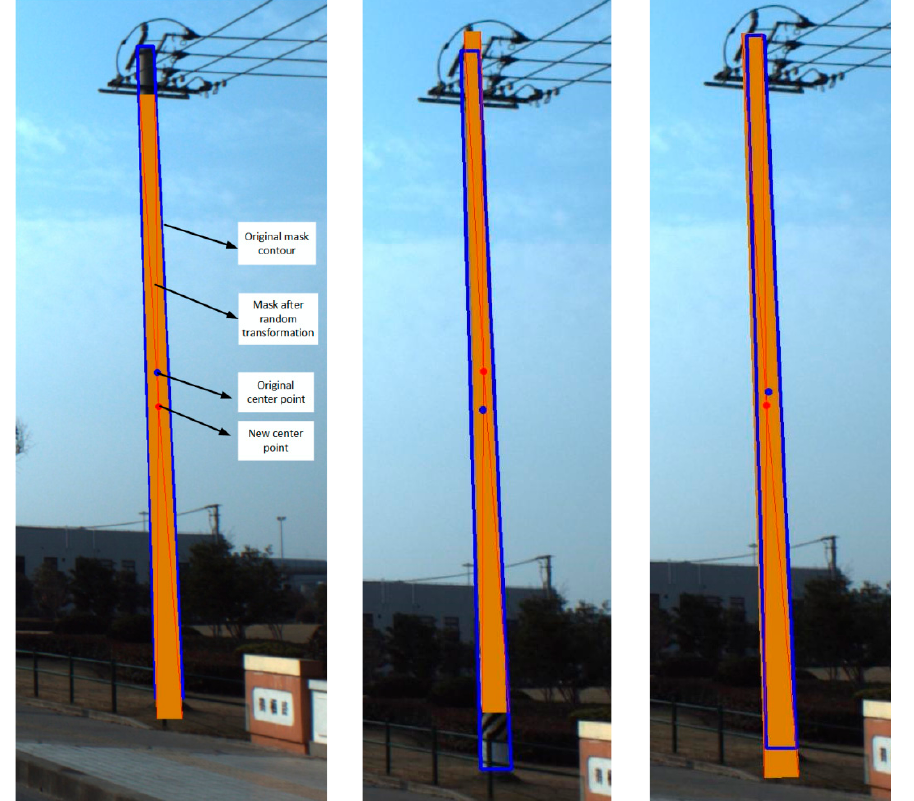
Figure 8. Mask random transformation results.